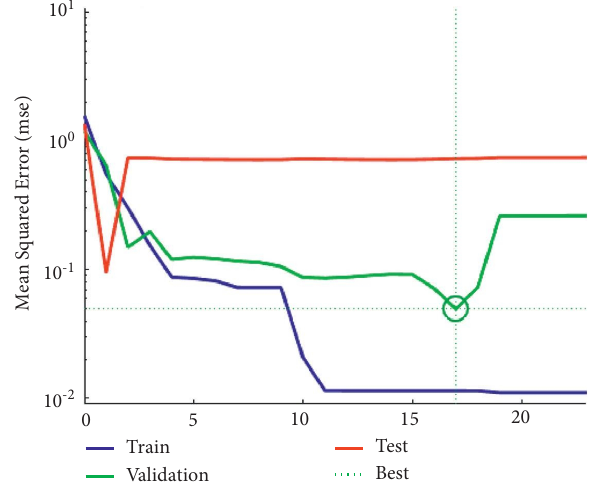
Figure 21: Training curve